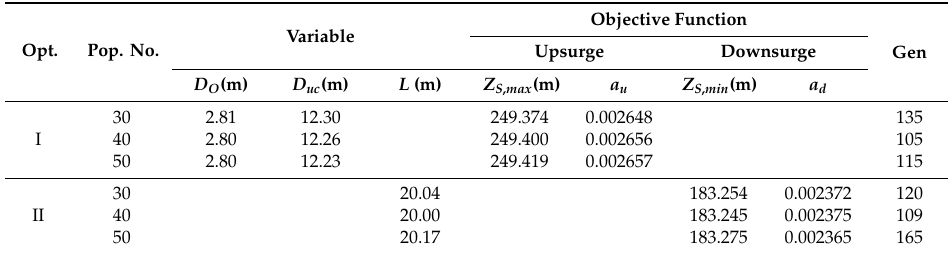
Table 4. Sensitivity analysis with different population size.